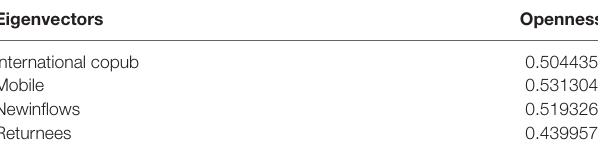
TaBle 2 | Component loadings on